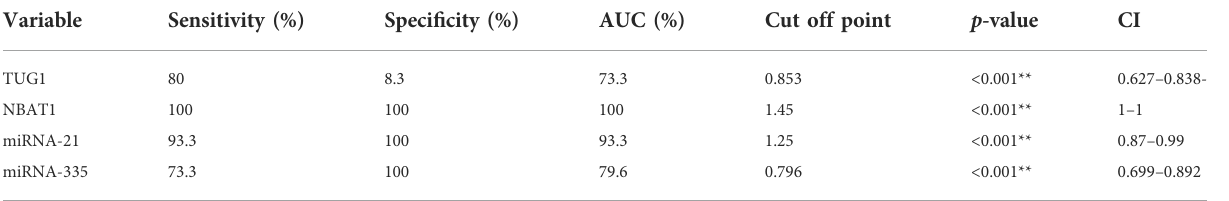
TABLE 7 Sensitivity and speci fi city of biomarkers in the diagnosis of AIS cases.